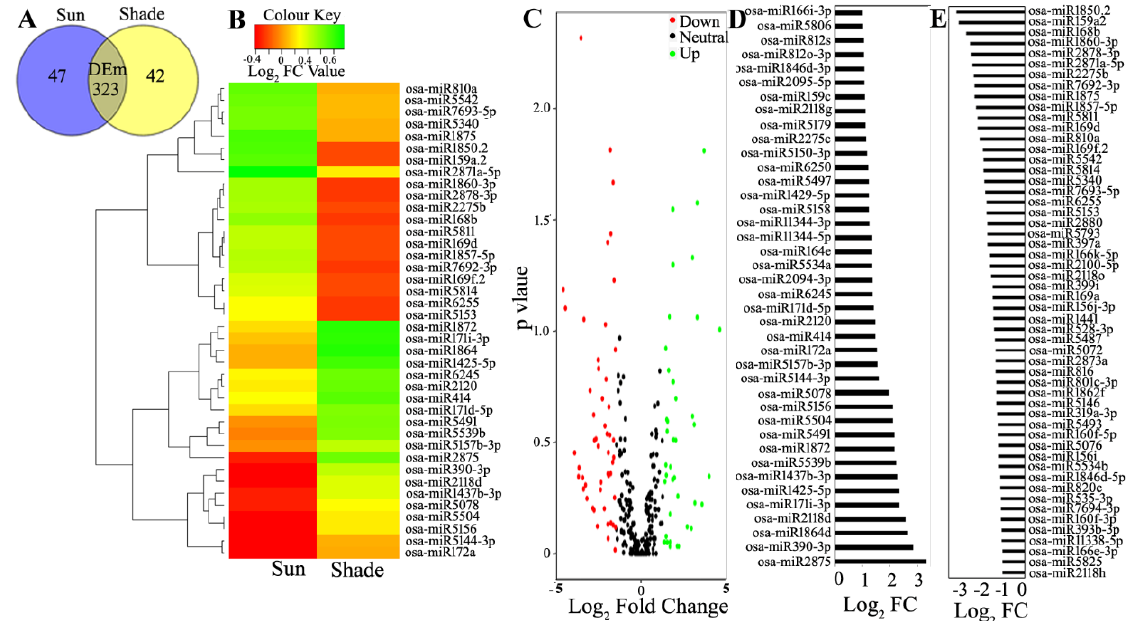
Figure 3. Differential expression analysis of the miRs (DEms) from sun- and shade-grown samples. ( A ) Venn diagram representation of DEms obtained under sun conditions, shade conditions, or commonly found conditions. ( B ) Heat-map analysis of the top 20 up- and downregulated known DEms. ( C ) Volcano plot of the known DEms. Color codes represent the differential regulation of the miRNA. Differential expression of ( D ) 40 up-DEms and ( E ) 54 down-DEms based on Log 2 fold-change ( − 1.0 > FC > 1.0 and p ≤ 0.9).